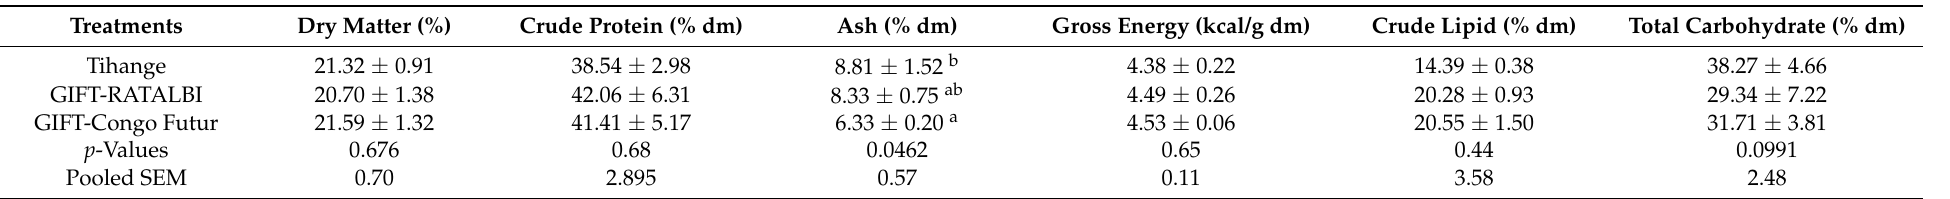
Table 7. Experiment 2 in Kinshasa, western lowlands DR Congo—whole body composition of Nile tilapia ( Oreochromis niloticus ) fingerlings of the “Tihange”,